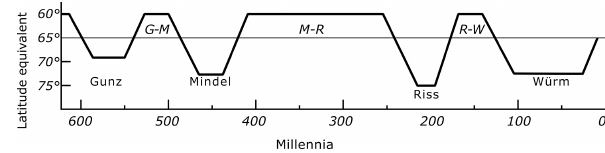
Figure 7. Penck and Brückner’s scheme of glacial–interglacial pe- riods in the Alpine glaciers. Reprinted from Kanon der Erdbe- strahlung und seine Anwendung auf das Eiszeitenproblem (p. 417) by Milankovitch (1941), Royal Serbian Academy Special Publica-